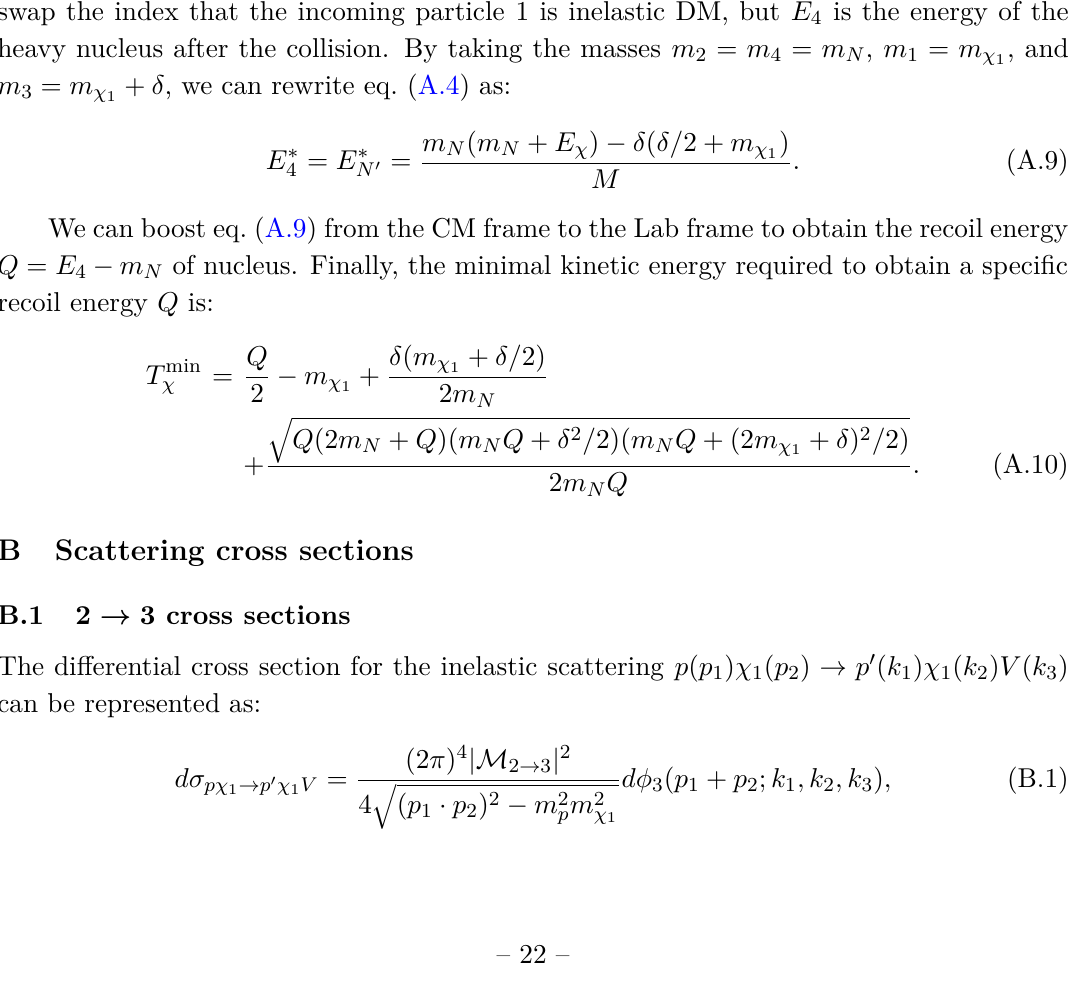
Figure 11. Kinetic relation between incoming E p and outgoing T χ represents T max with θ ∗ = π , and the blue curve represents T min χ 2 region is between the red and blue curves. The two curves can be uniformly described by eq. (A.8). Two limits of the curve correspond to two kinematic constraints for inelastic collision: T kin and E kin = m + δ + δ ( δ +2 m p ) p p 2 m χ 1